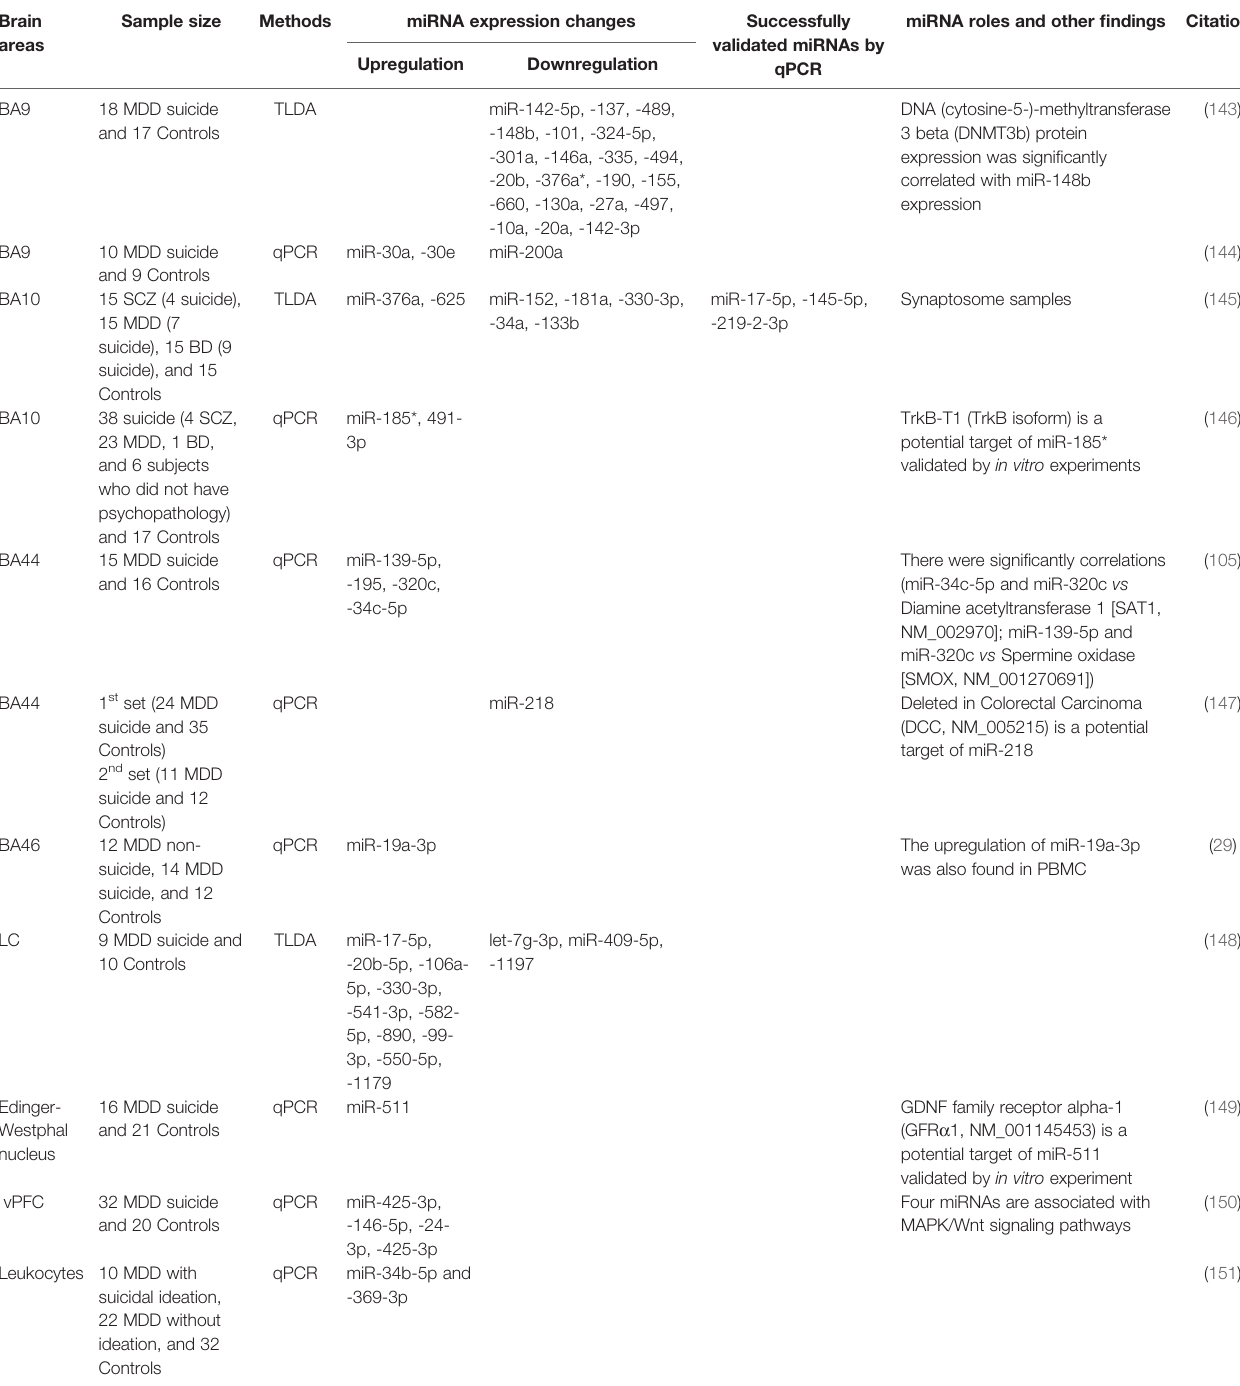
TABLE 4 | miRNA expression changes in postmortem brain and blood samples of suicide subjects. Brain